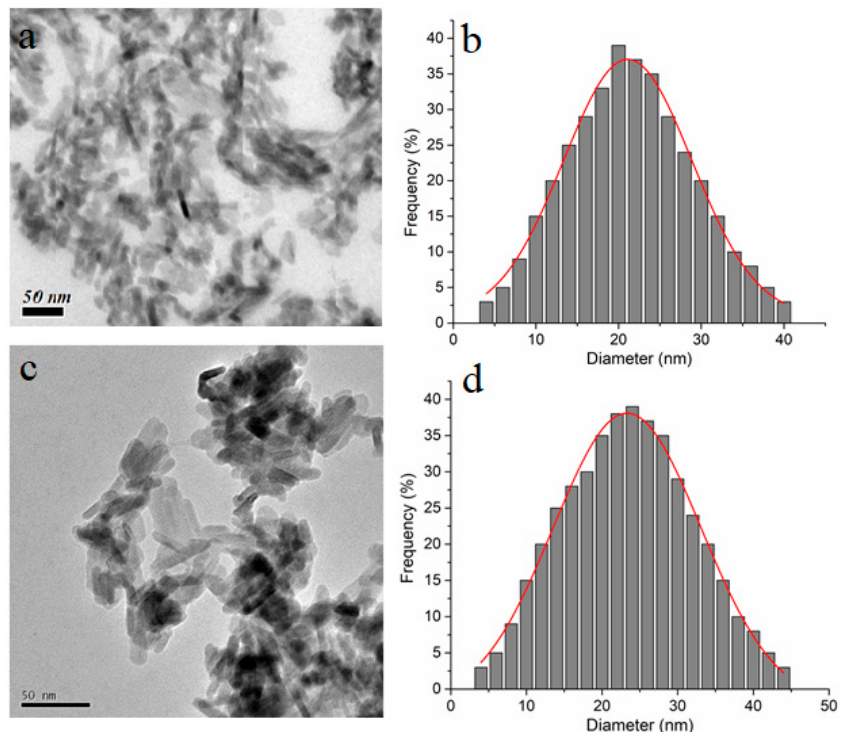
Figure 2. TEM image of HAp ( a ) and HApWW ( c ) nanoparticles. Distribution of HAp ( b ) and HApWW ( d ) nanoparticles obtained from TEM images.